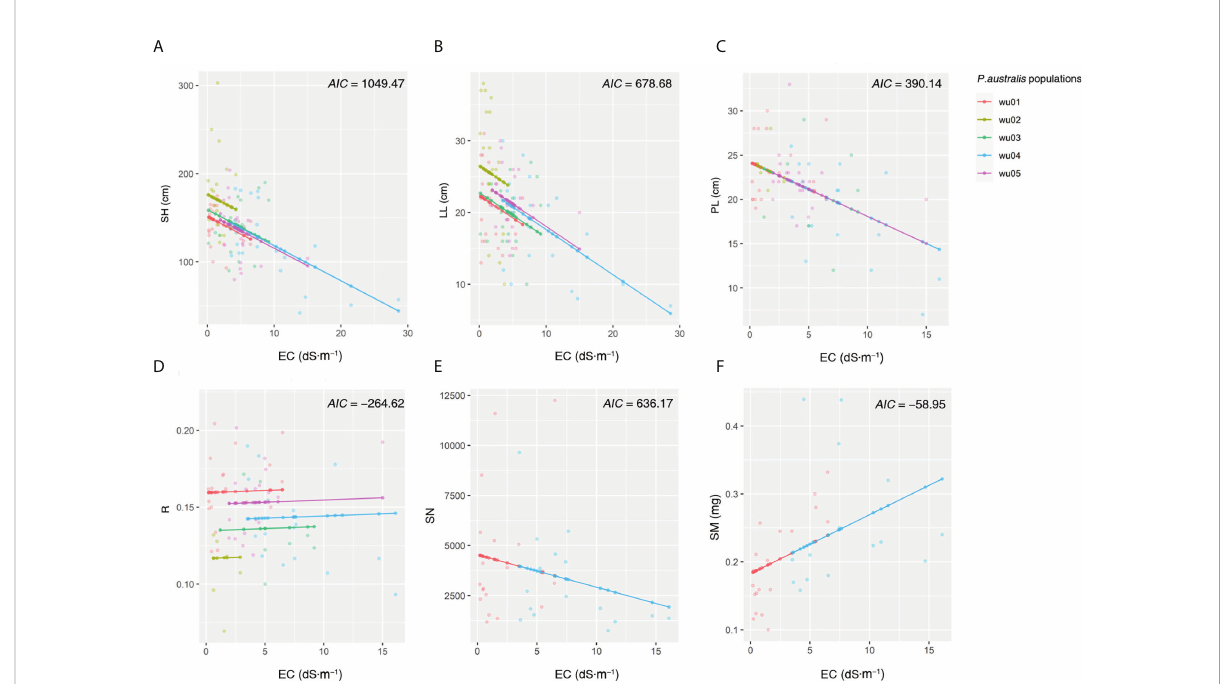
FIGURE 4 Relationships between Phragmites australis traits (A , shoot height; B , leaf length; C , panicle length; D , reproductive allocation, i.e., the ratio of panicle length to shoot height; E , seed number per panicle; F , mass per seed ) and electrical conductivity in fi ve populations based on linear mixed models with the random factor of site.